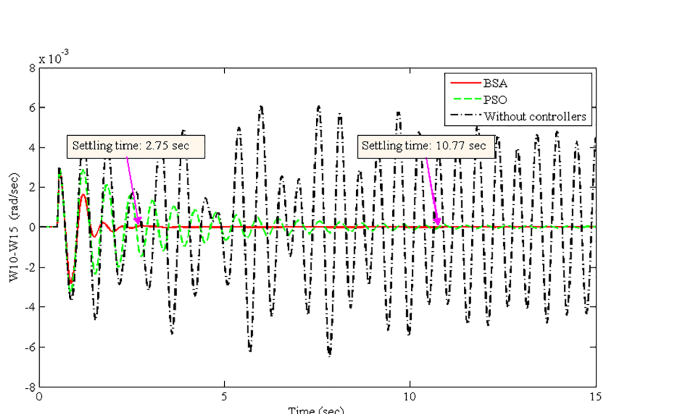
Fig 10. Inter-area mode between G13 in area 5 and G16 in area 3 (W13-W16) for the 3-phase fault at bus 1.